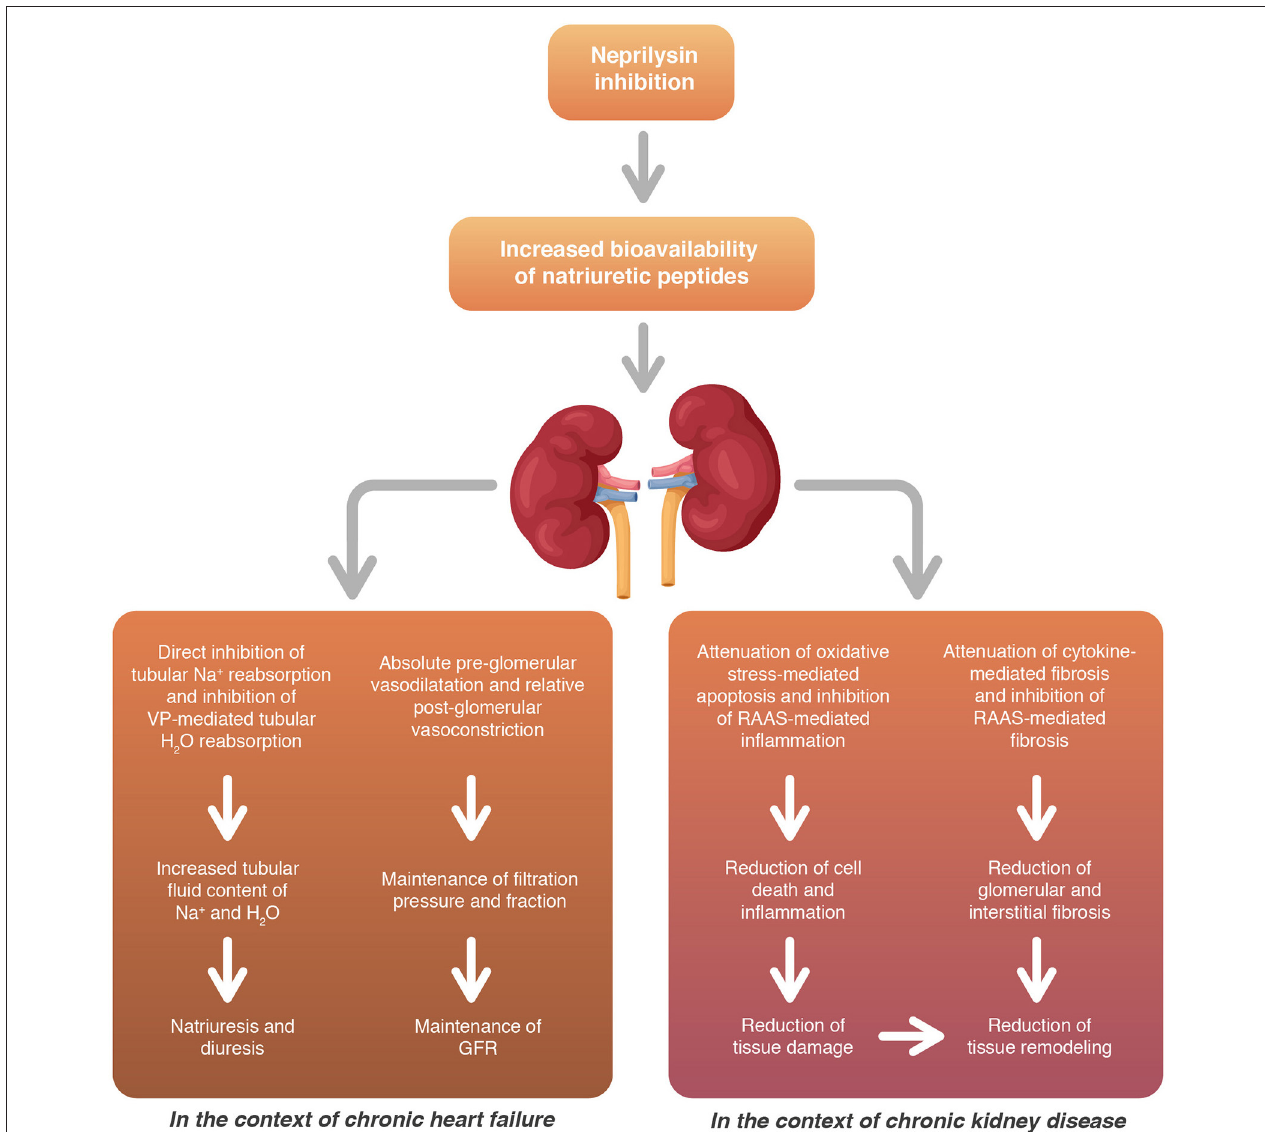
FIGURE 6 | Neprilysin/RAAS inhibition provides several renal benefits both in terms of functional adaptations and structural remodeling. RAAS, renin-angiotensin-aldosterone system; GFR, glomerular filtration rate; VP,